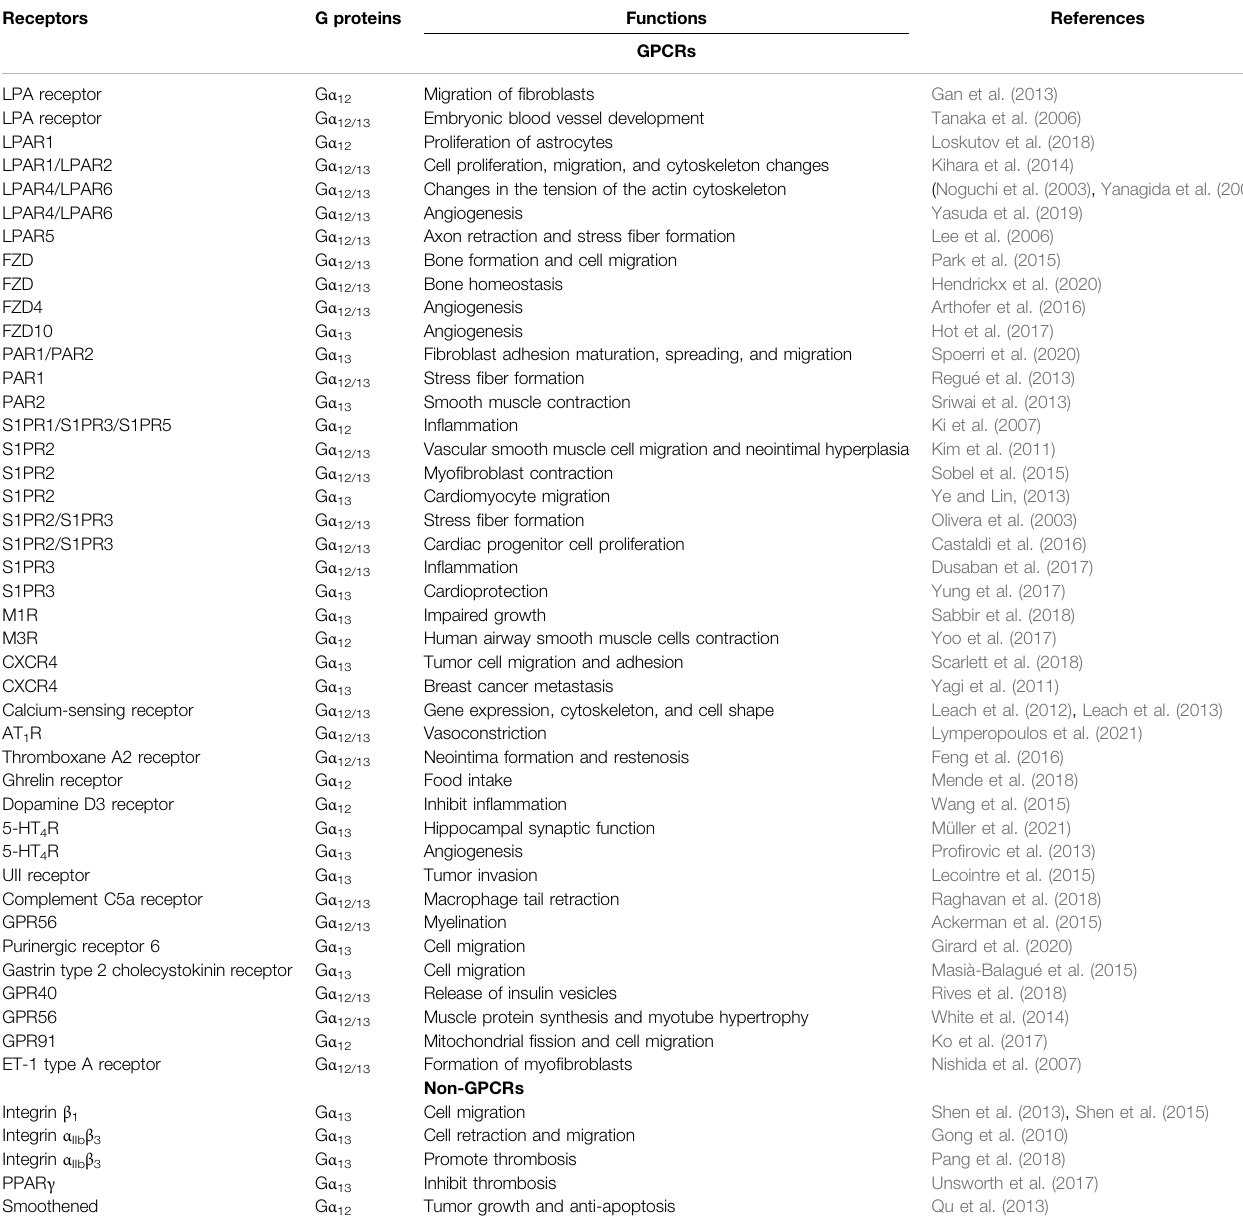
TABLE 1 | List of biologically signi fi cant G α 12/13 -associated receptors and their physiological functions.